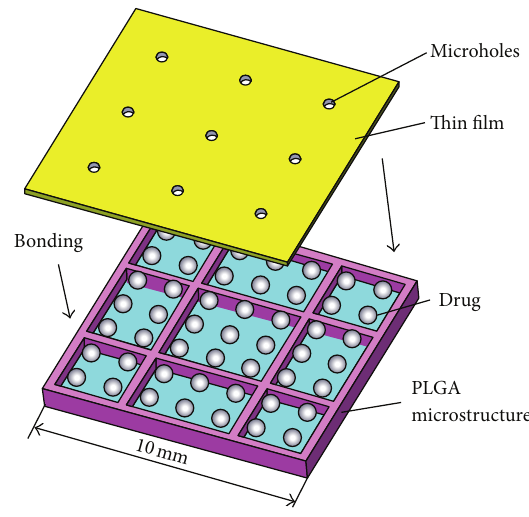
Figure 1: PLGA drug delivery